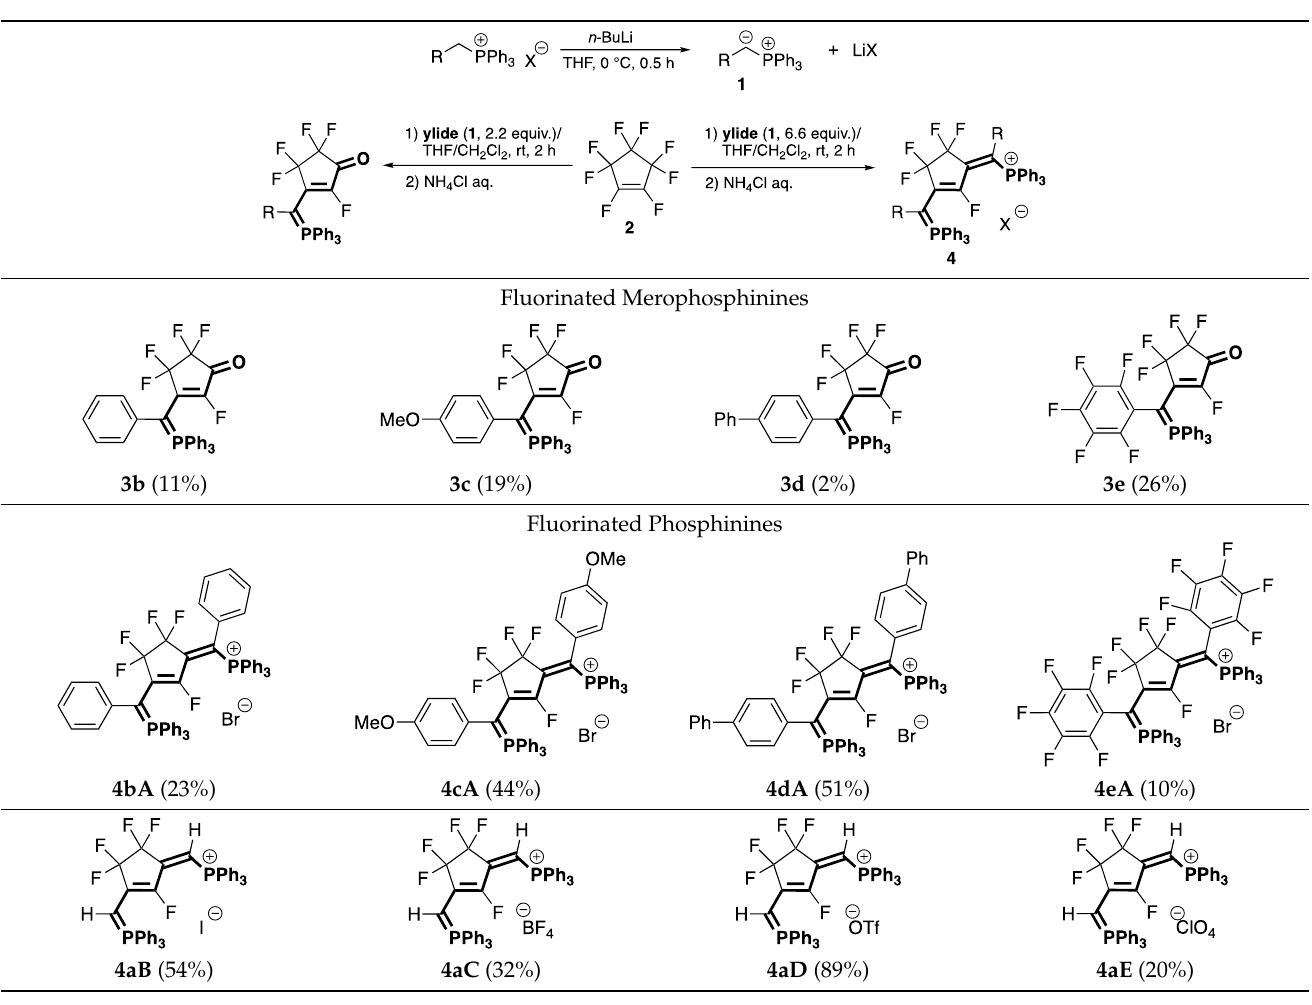
Table 1. Synthesis of the fluorinated merophosphinines ( 3 ) and phosphinines ( 4 ). (The values in parentheses are the isolated yields).